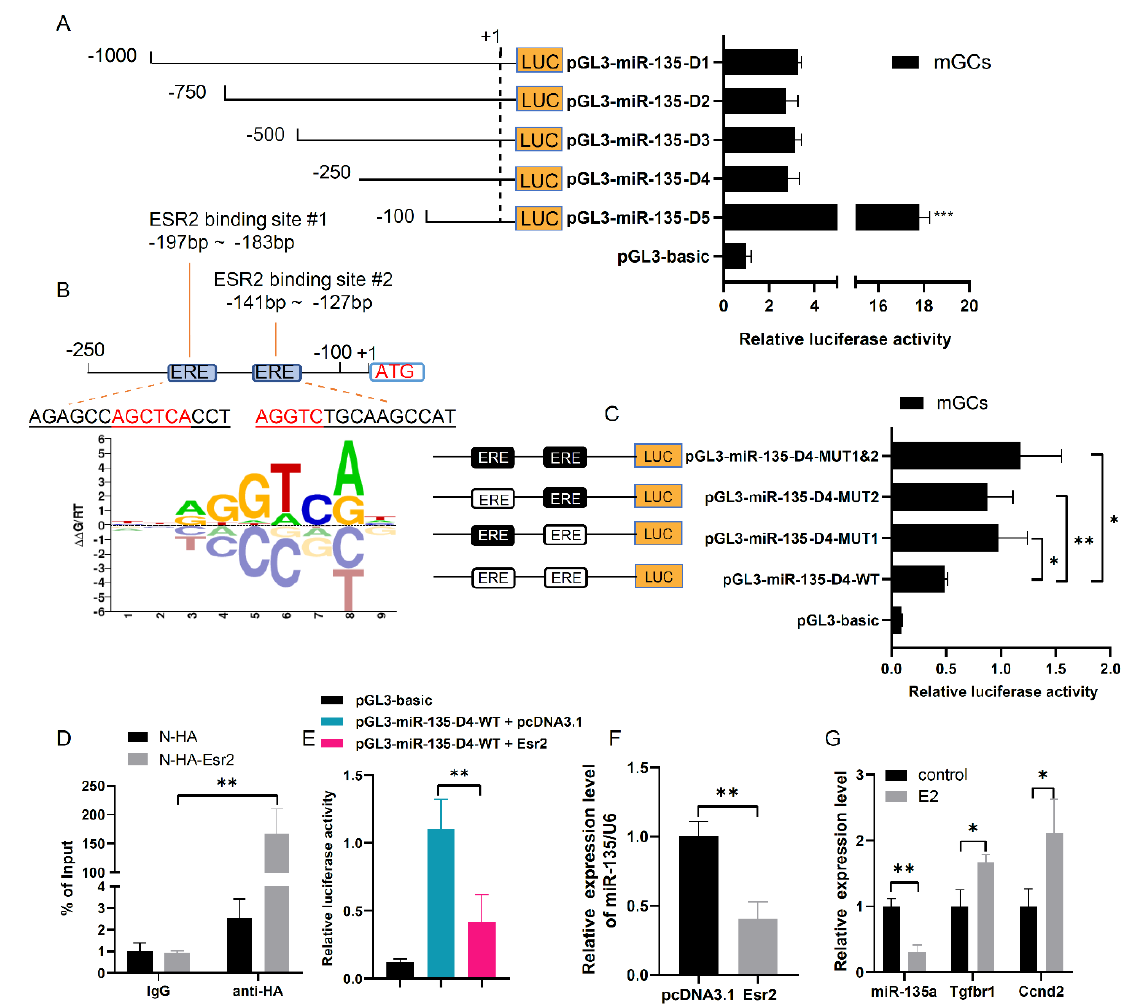
Figure 5. ESR2 negatively regulates miR-135a expression via binding to miR-135a promoter region. ( A ) Luciferase activity assay of a series of truncated miR-135a promoters in mGCs. ( B ) Schematic diagram of miR-135a promoter. ( C ) Site-directed mutation analysis of the miR-135a promoter using luciferase activity assays. Two intact ESR2 binding sites were indicated by empty boxes, respectively. The filled boxes showed the corresponding mutations. ( D ) ChIP analyses of ESR2 binding sites in miR-135a promoter region followed by qPCR. mGCs expressing N-HA were assayed as a control to exclude the possibility of nonspecific binding of anti-HA. ( E ) Luciferase activity of miR-135a promoter was downregulated in Esr2 overexpressed mGCs. ( F ) Relative level of miR-135a in Esr2 overexpressed mGCs. ( G ) Relative level of miR-135a, Tgfbr1 and Ccnd2 expression in estrogen-treated mGCs. The means ± SD were calculated from three independent experiments. * p < 0.05, ** p < 0.01, *** p < 0.001.